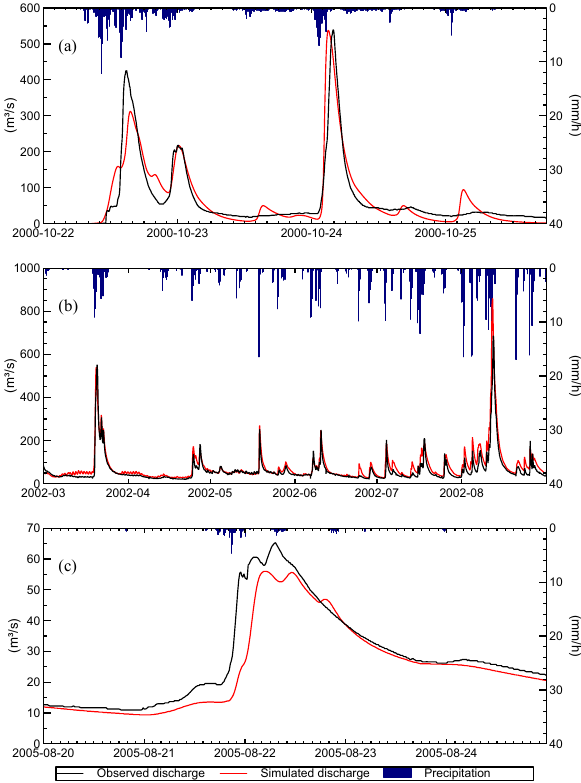
Fig. 7. Calibration periods at catchments: (a) Poyo, (b) Upper Iller and (c)